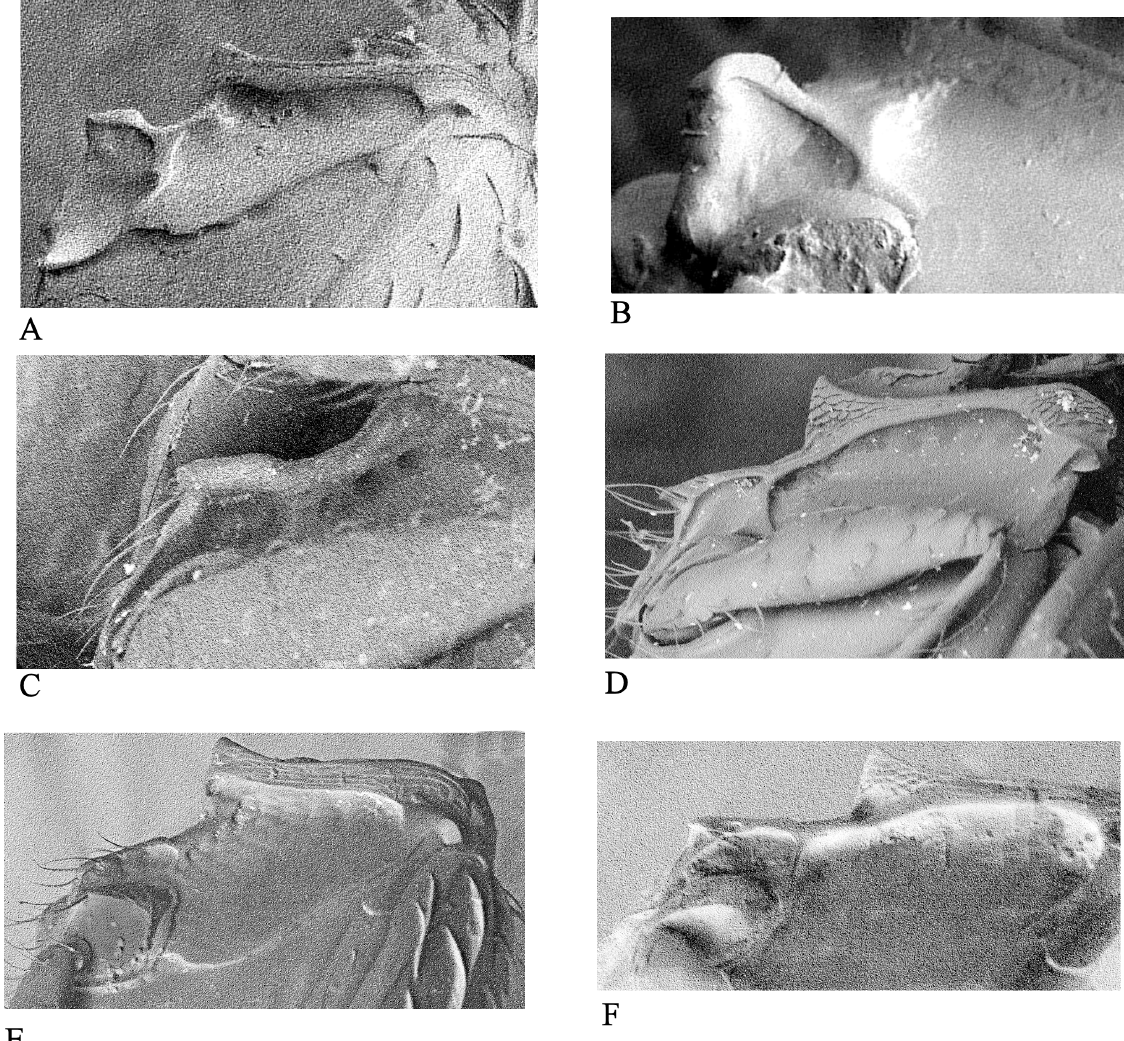
Fig. 5. Figures to show keel shapes. A . Cissidium bifoveolatum sp. nov., × 515. B . Cissidium lucidulum sp. nov., × 780. C . Cissidium scutellaris (Deane, 1931), × 1480. D . Cissidium tigrum Darby, 2015, × 840. E . Cissidium sawadai Darby, 2015, × 680. F . Cissidium lisae Darby, 2015,